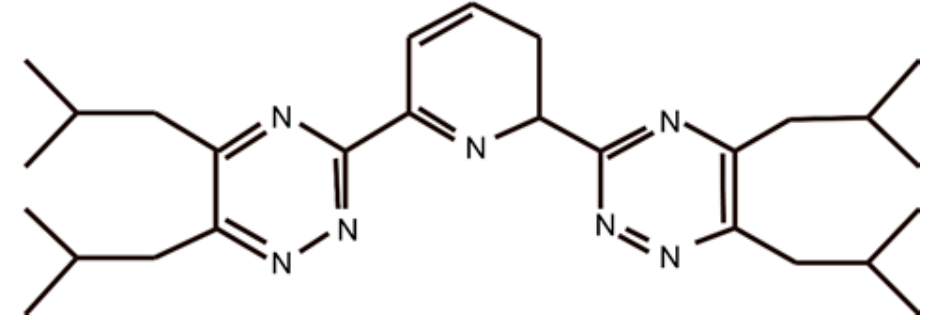
Figure 14. Chemical structure of isobutyl-BTP(2,6-diisobutyl-1,2,4-triazin-3-yl) pyridine) [59]. Nanomaterials 2019 , 9 , x FOR PEER REVIEW